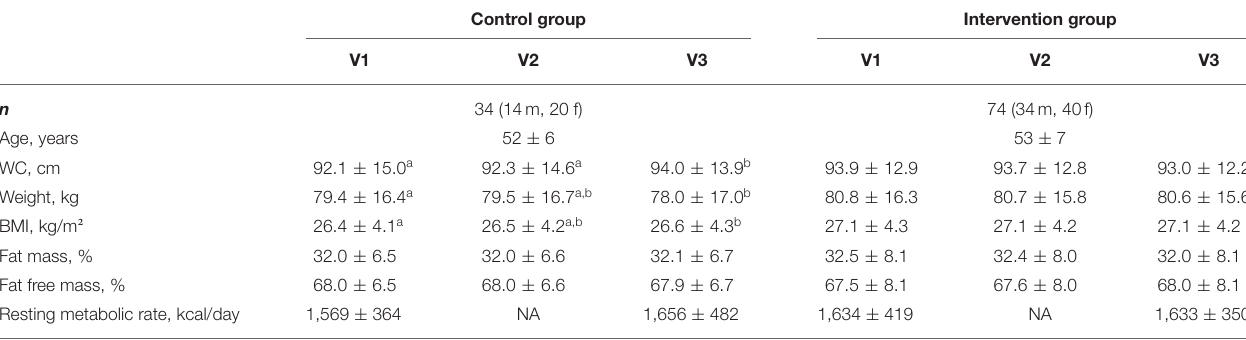
TABLE 1 | Baseline and follow-up characteristics of the participants and changes of anthropometric parameters during the study.